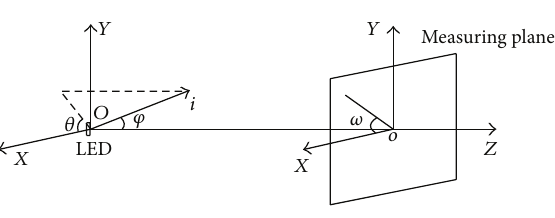
Figure 2: Coordinates setup.